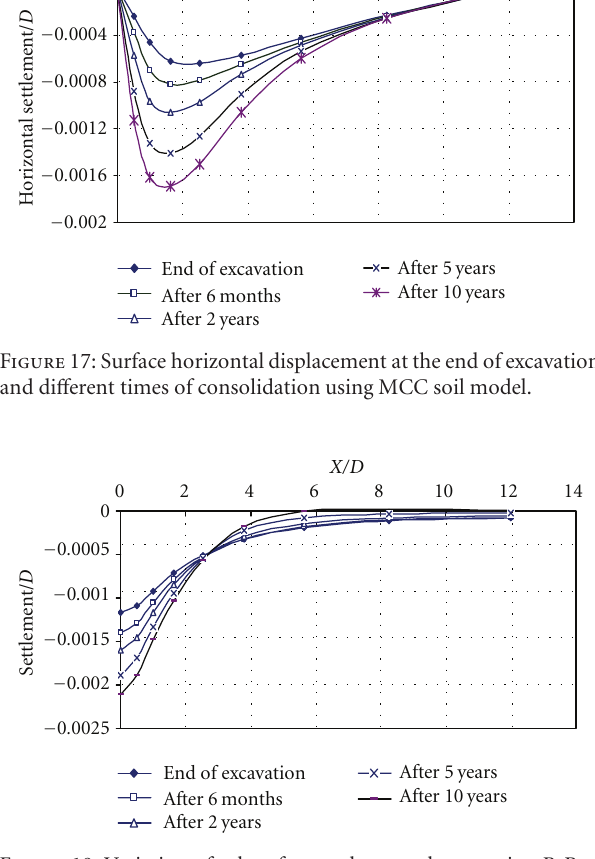
Figure 18: Variation of subsurface settlement along section B-B at di ff erent consolidation times using MCC soil